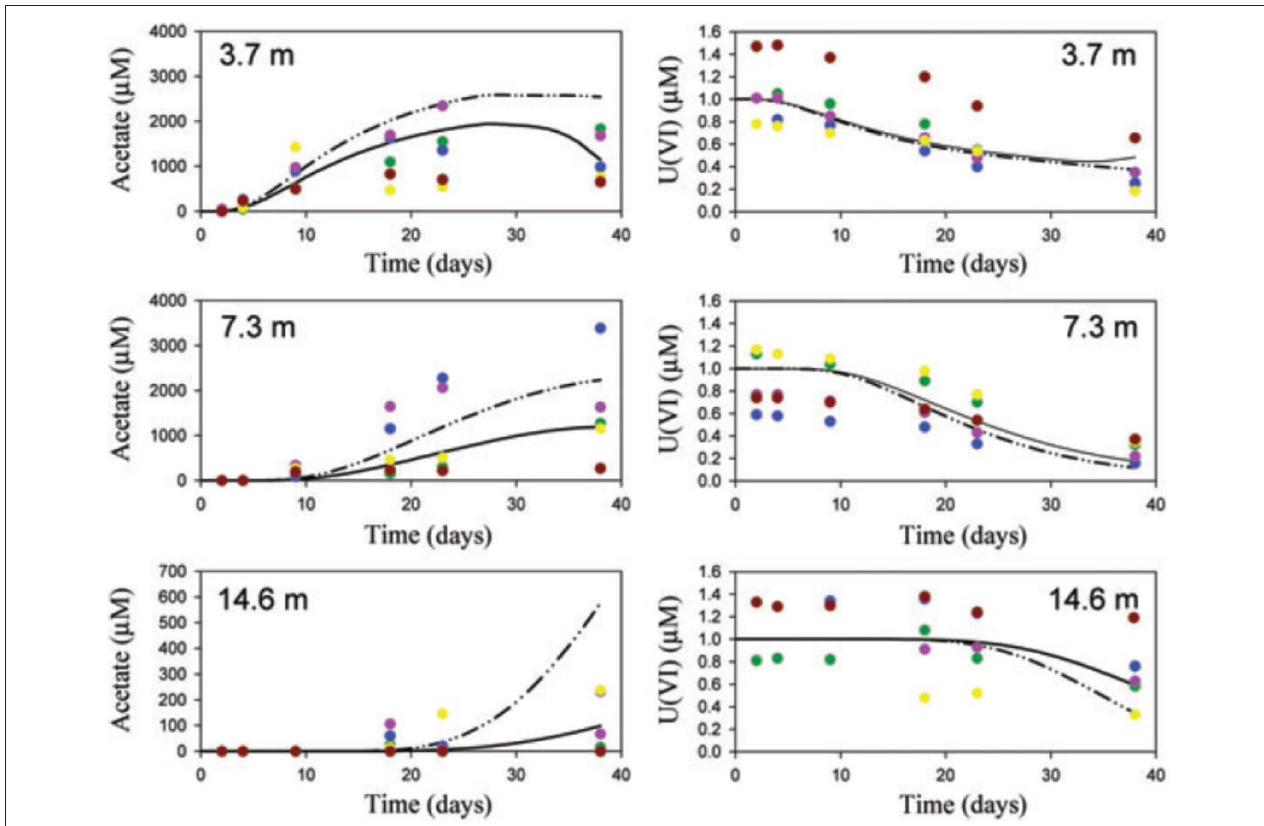
FIGURE 2 | Comparison of observations (symbols), traditional model (solid lines) and FBA-based model (dashed lines). Reproduced from Scheibe et al. (2009) with permission. The figure shows acetate and U(VI) concentrations at a groundwater bioremediation site. Concentration time series are presented at 3.7, 7.3, and 14.6m distance from the acetate injection gallery. Acetate increases at progressively later times as the distance from the injection gallery increases. Consistent with this, U(VI) decreases at progressively later times. Colors identify single